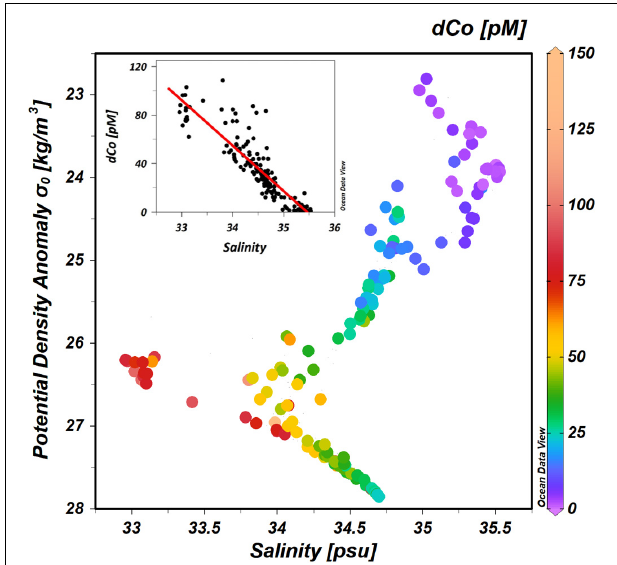
FIGURE 14 | Dissolved Co in the NPIW: The highest concentrations of dCo (pM) are found in the lowest salinity water and in the 26.0–27.3 σ θ isopycnal range. Linear regression line of dCo and salinity is described by the equation [dCo (pM)] = (–37.8 ± 1.6) × (salinity) + (1325 ± 55); r 2 = 0.789.